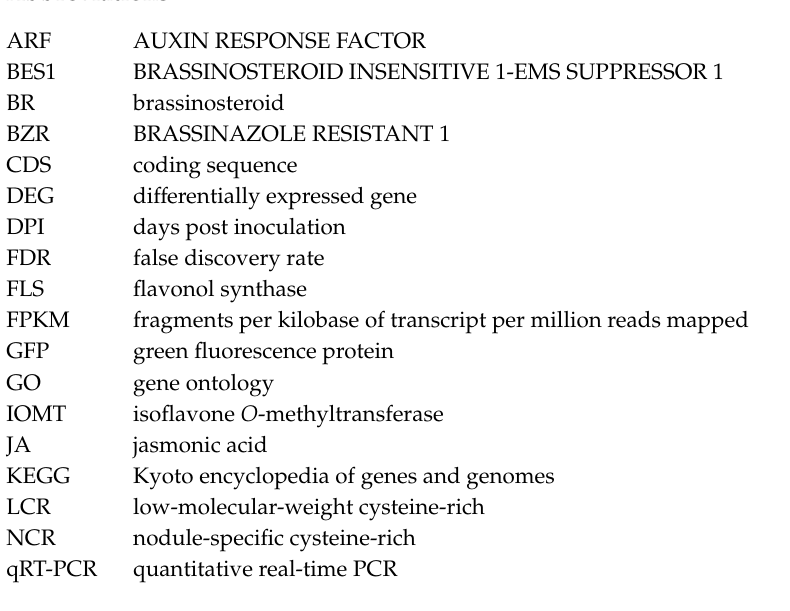
all genes in WT and mtbzr1-1